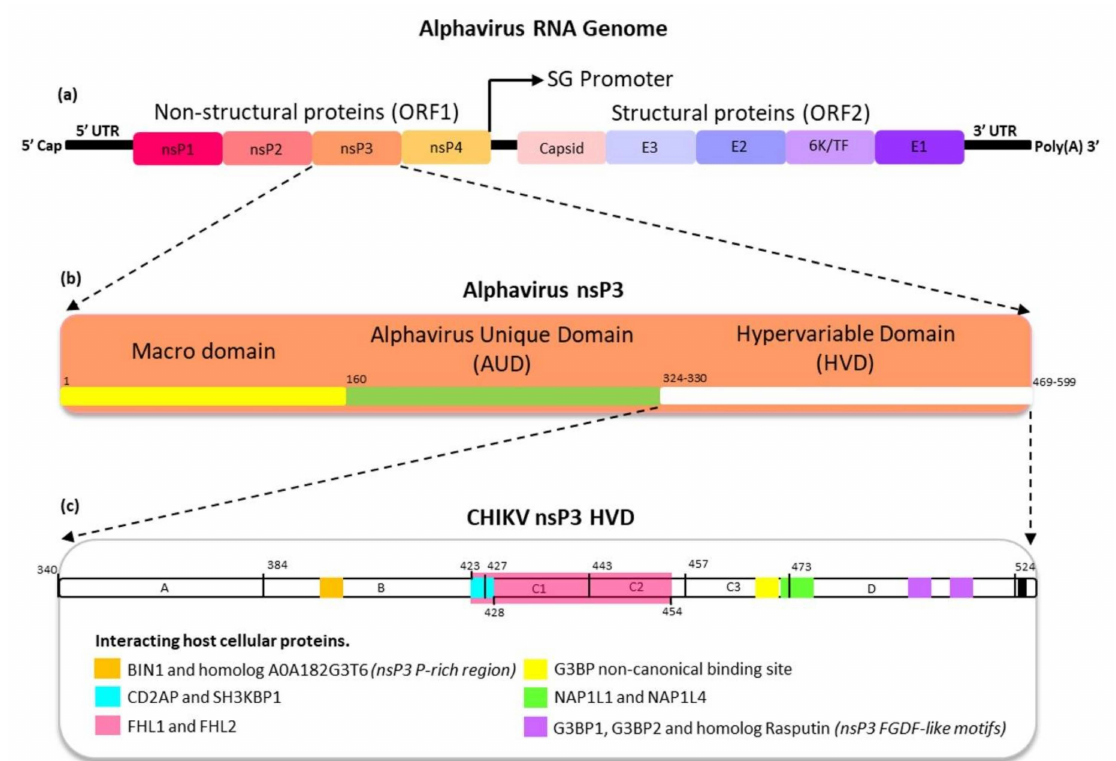
Figure 1. A summary of the alphavirus ss(+)RNA genome and nsP3 characteristics with putative binding regions for various host proteins. ( a ) The ~12 kb alphavirus RNA genome encodes four non-structural proteins (ORF1) and six structural proteins (ORF2), including the newly discovered TF protein. These ORFs are flanked by 5 (cid:48) and 3 (cid:48) UTRs. ( b ) The size of the alphavirus nsP3 ORF may vary (1–469/599 bp) and contains three domains: the macrodomain at position 1–160 bp (yellow), the alphavirus unique domain at position 161–324/330 bp (green), and the hypervariable domain at position 324/331–469/599 (white). ( c ) The nsP3 hypervariable domain (HVD) with putative binding regions for various interacting host proteins indicated according to the most recent available information. The putative nsP3 regions interacting with host proteins have been highlighted with different colors. UTR—untranslated region; ORF—open reading frame; SG—subgenomic promoter; Poly(A)—polyadenylation; BIN1—bridging integrator 1; CD2AP—CD2-associated protein; SH3KBP1—SH3 domain containing kinase binding protein 1; FHL1—four and a half LIM domain protein 1; FHL2—four and a half LIM domain protein 2; G3BP—ras-GTPase-activating protein (Ras-GAP) SH3 domain binding protein; G3BP1—ras GTPase-activating protein-binding protein 1; G3BP2—ras GTPase-activating protein-binding protein 2; NAP1L1—nucleosome assembly protein 1 like 1 and NAP1L4—nucleosome assembly protein 1 like 4. This figure is modified from Ahola and Merits, 2016; Gotte, Liu, and McInerney, 2018; Meshram et al., 2018; and Schnierle,